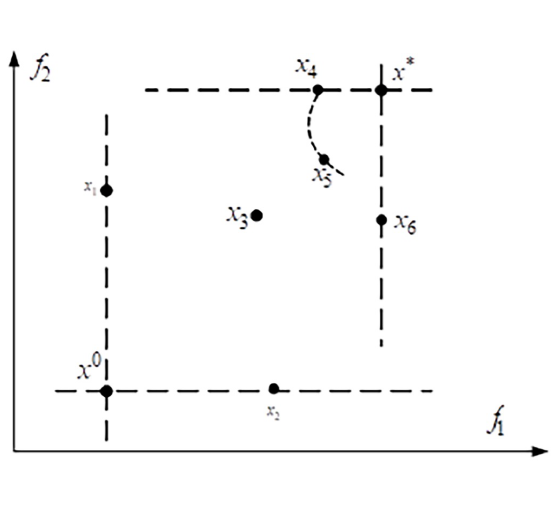
Fig. 1 Ideal solution and negative ideal solution